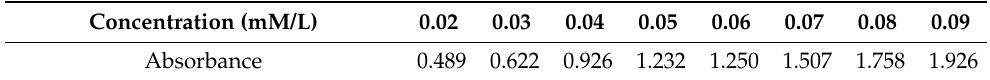
Table 1. UV absorbance of rutin–ethanol solution with different concentrations.